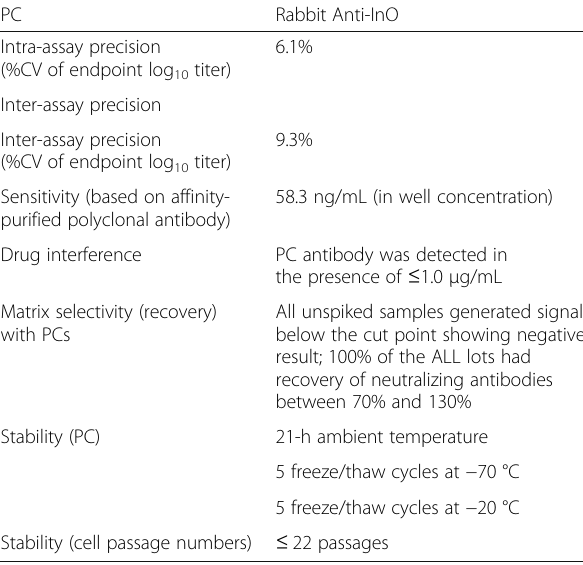
Table 3 Highlights of neutralizing antibody assay validation